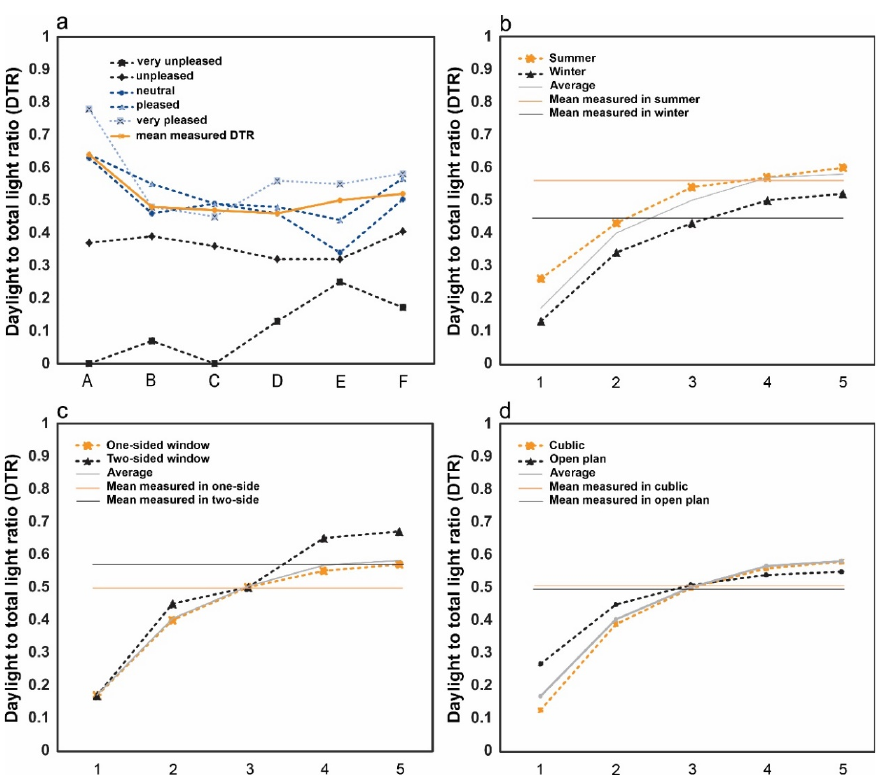
Figure 5. DTR satisfaction. Separated by building ( a ), separated by season ( b ), separated by window type ( c ), separated by office type ( d ). Note: For graph 1–5, 1 = very unpleasant, 2 = unpleasant, 3 = neutral, 4 = pleasant, 5 = very pleasant.